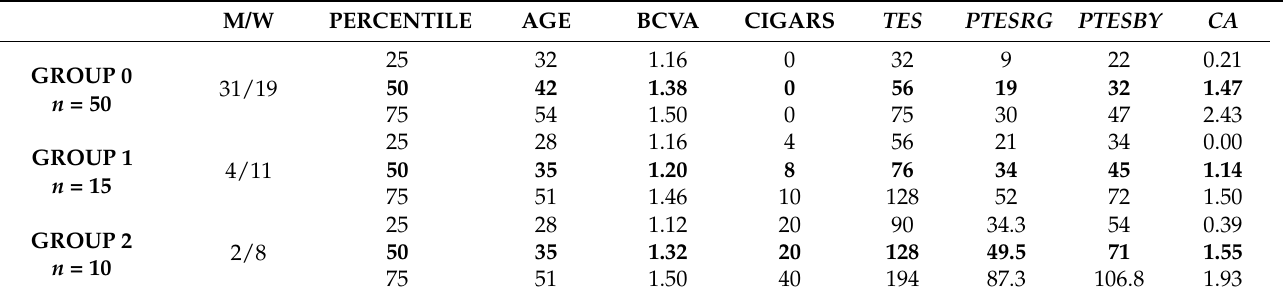
Table 1. Data of 25, 50, and 75 percentiles by group for age, best-corrected visual acuity ( BCVA ), number of consumed cigarettes (CIGARS), FM100h scores (total scores ( TES ) and partial scores) for the red-green and blue-yellow mechanisms ( PTESRG, PTESBY , respectively), colour axis index ( CA ), and gender (M: men; W: